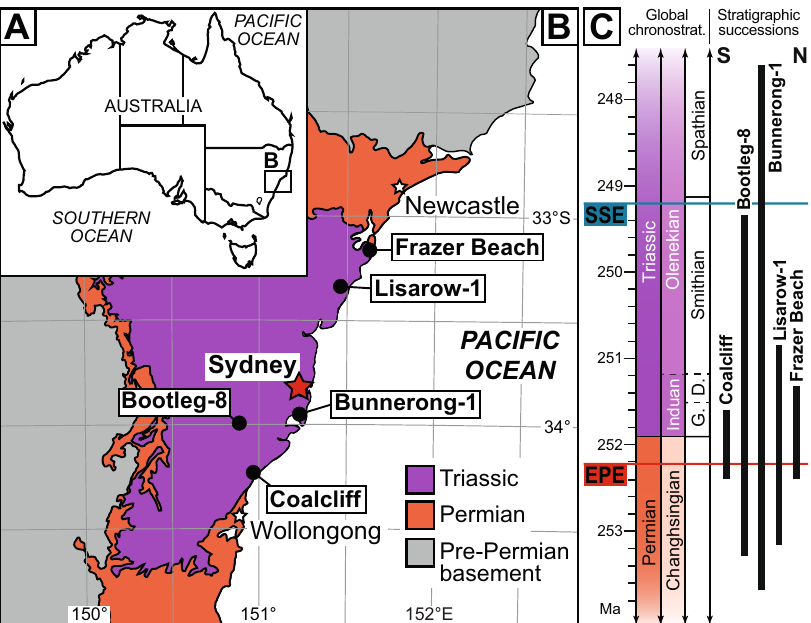
Fig. 1 Geologic map and stratigraphy of the Sydney Basin, Australia. A Map of modern Australia. B Geological map of southeastern Sydney Basin, with the locations of the studied core and outcrop successions. C Stratigraphic ranges of the examined Sydney Basin successions 10,13,16 and correlation to the global upper Permian and Lower Triassic chronostratigraphy (chronostrat.) 13 – 15 ; EPE = end-Permian extinction event, Ma = millions of years ago, SSE = Smithian-Spathian climatic event, D. = Dienerian, G. = Griesbachian Stage, N = north, S =